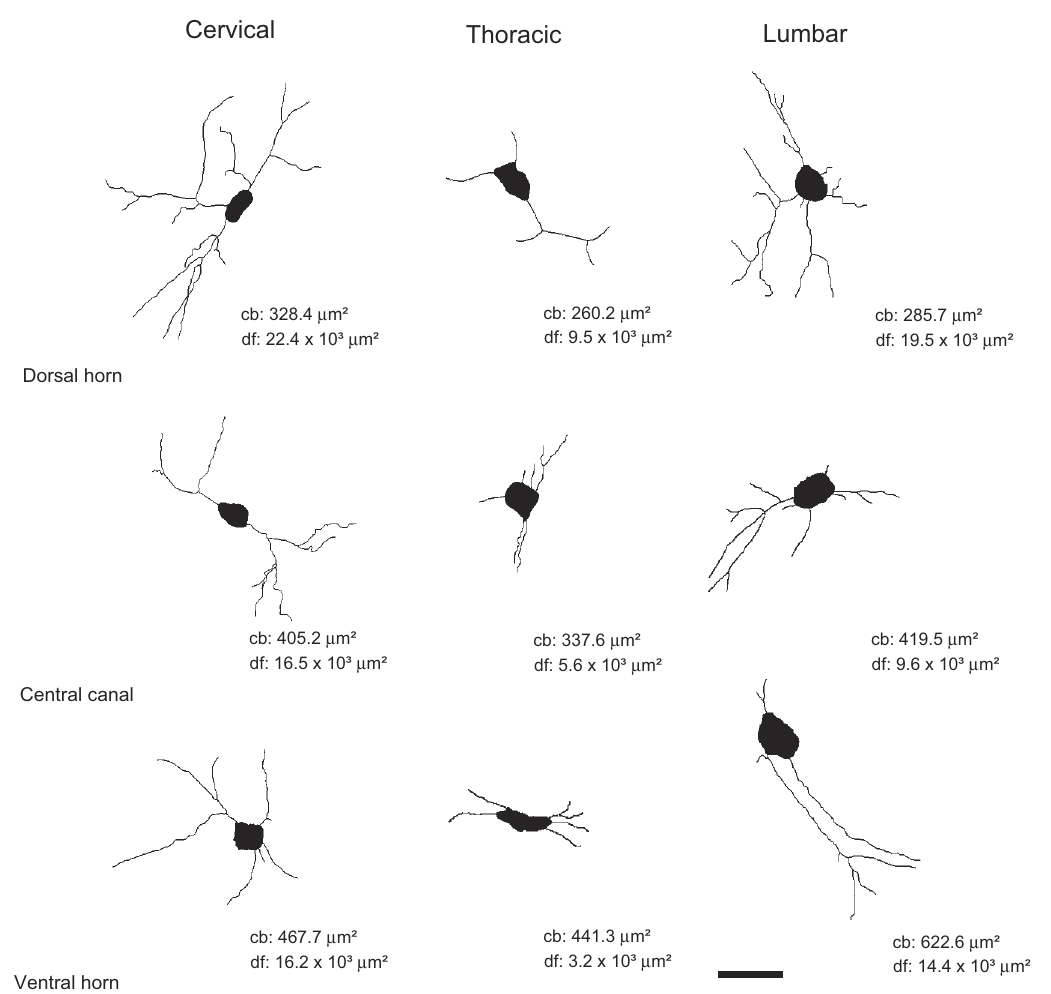
Figure 5. Computer-aided reconstruction of NADPH-d neurons across distinct regions of the spinal cord. Cells in the cervical enlargement, especially in the dorsal horn and central canal, possess a more elaborated dendritic arborization than those located in other segments. Cells in thoracic segments are poorly ramifi ed. Legends: cb: cell body area in µm 2 ; df: dendritic fi eld coverage area in µm 2 . Scale bar: 30